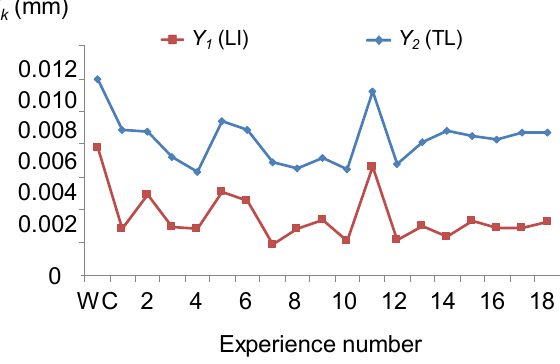
Figure 8. Set of responses Y 1 and Y 2 . Table 4. Estimated coefficients for ˆ Y 1 and ˆ Y 2 quadratic